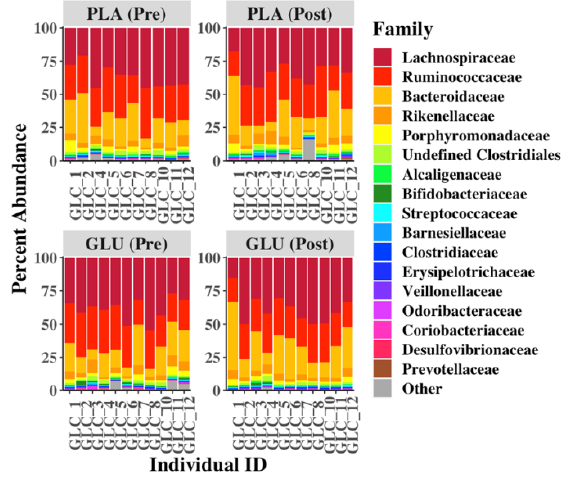
Figure 4. Relative abundance of bacteria shown at the family level. Proportions of individual bacterial families pre- and post-GLU and -PLA consumption. ASVs were combined if their family-level taxonomic designations were identical. The seventeen most abundant bacterial families are annotated, with all other taxa grouped under the annotation of “Other”.